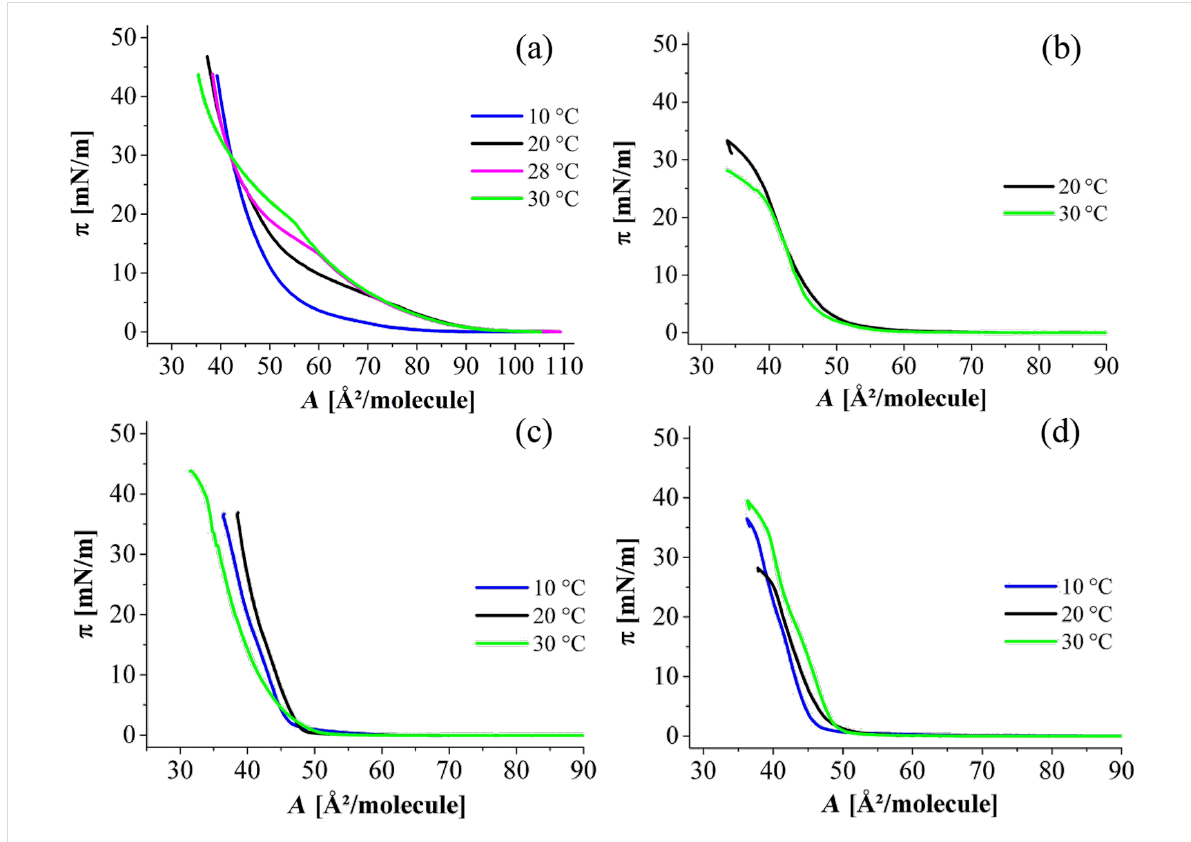
Figure 2: Surface pressure–area isotherms at (a) pH 9 without calcium (borax buffer with 150 mM NaCl and 1 mM EDTA), (b) pH 9 with calcium (borax buffer with 1 mM CaCl 2 and 150 mM NaCl), (c) pH 4 without calcium (citric buffer with 150 mM NaCl and 1 mM EDTA), and (d) pH 4 with calcium (citric buffer with 1 mM CaCl 2 and 150 mM NaCl) at different temperatures (indicated).